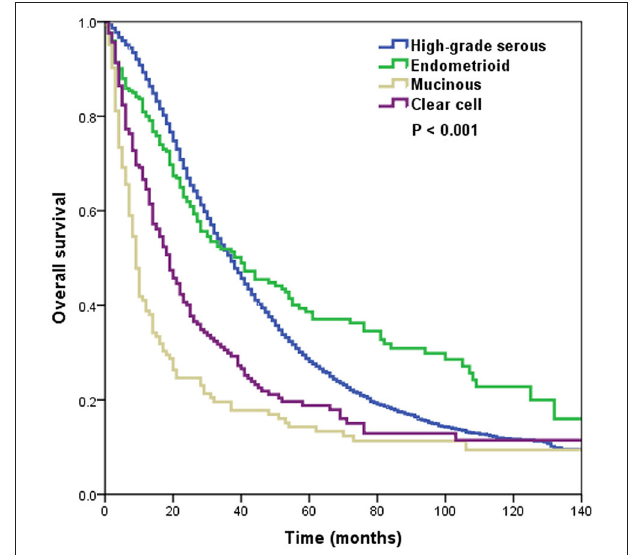
FIGURE 1 | Overall survival by histological